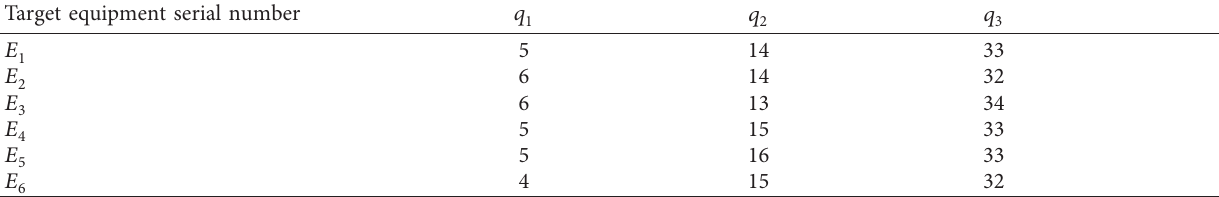
Table 5: Ammunition consumption data under different damage degrees of armor targets.